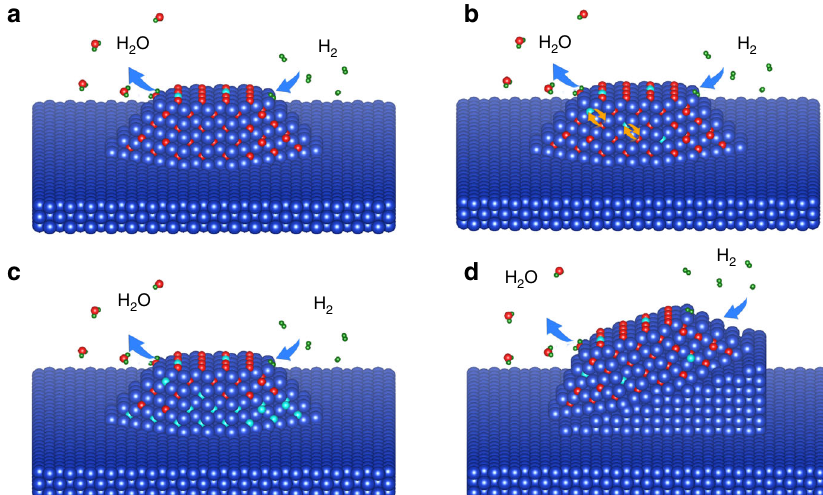
Fig. 6 Pictorial illustration of the Cu 2 O island rotation. a Reaction of H 2 molecules with lattice oxygen in Cu 2 O forms H 2 O molecules that desorb from the surface, leaving behind oxygen vacancies. b Oxygen vacancies migrate through the oxide layer toward the Cu 2 O/Cu interface. c Oxygen vacancies accumulate near the Cu 2 O/Cu interface region. d Abrupt collapse of the Cu 2 O lattice in the interface region into Cu results in the formation of a stepped Cu plateau, which drives the rotation of the entire Cu 2 O island. Blue , red , green and cyan spheres represent Cu, O and H atoms, and O vacancies,